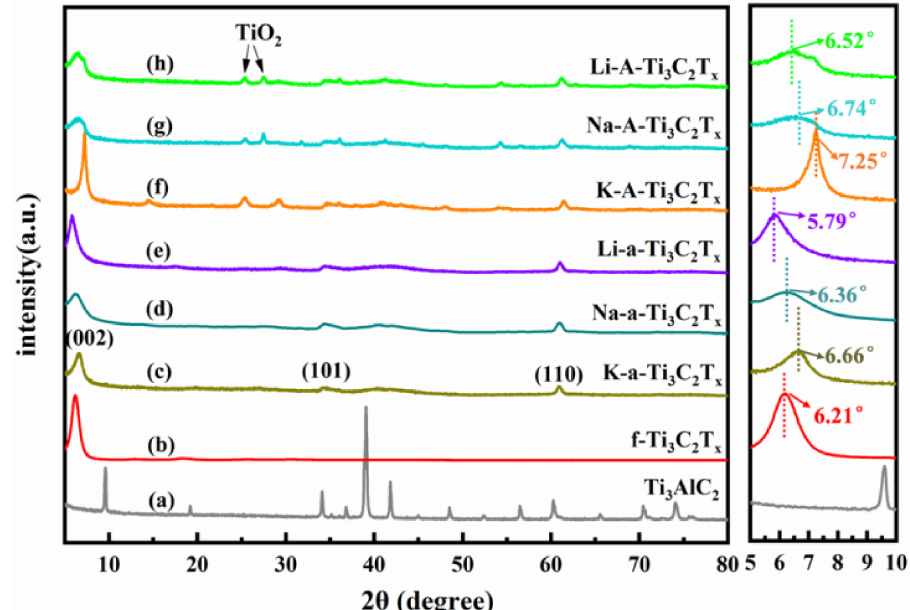
Figure 3. XRD patterns of ( a ) Ti 3 AlC 2 , ( b ) f-Ti 3 C 2 T x , ( c ) K-a-Ti 3 C 2 T x , ( d ) Na-a-Ti 3 C 2 T x , ( e ) Li-a-Ti 3 C 2 Tx, ( f ) K-A-Ti 3 C 2 T x , ( g ) Na-A-Ti 3 C 2 T x , and ( h ) Li-A-Ti 3 C 2 T x . The right side of